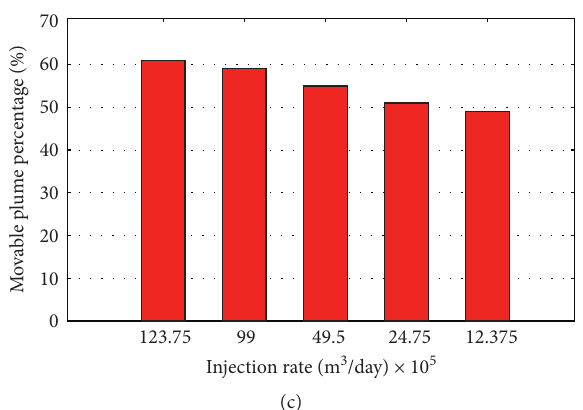
Figure 7: Illustration of (a) structural trapping, (b) residual trapping, and (c) movable plume at injection point B for varying injection rates 123.75 × 10 5 , 99 × 10 5 , 49.5 × 10 5 , 24.75 × 10 5 , and 12.375 × 10 5 m 3